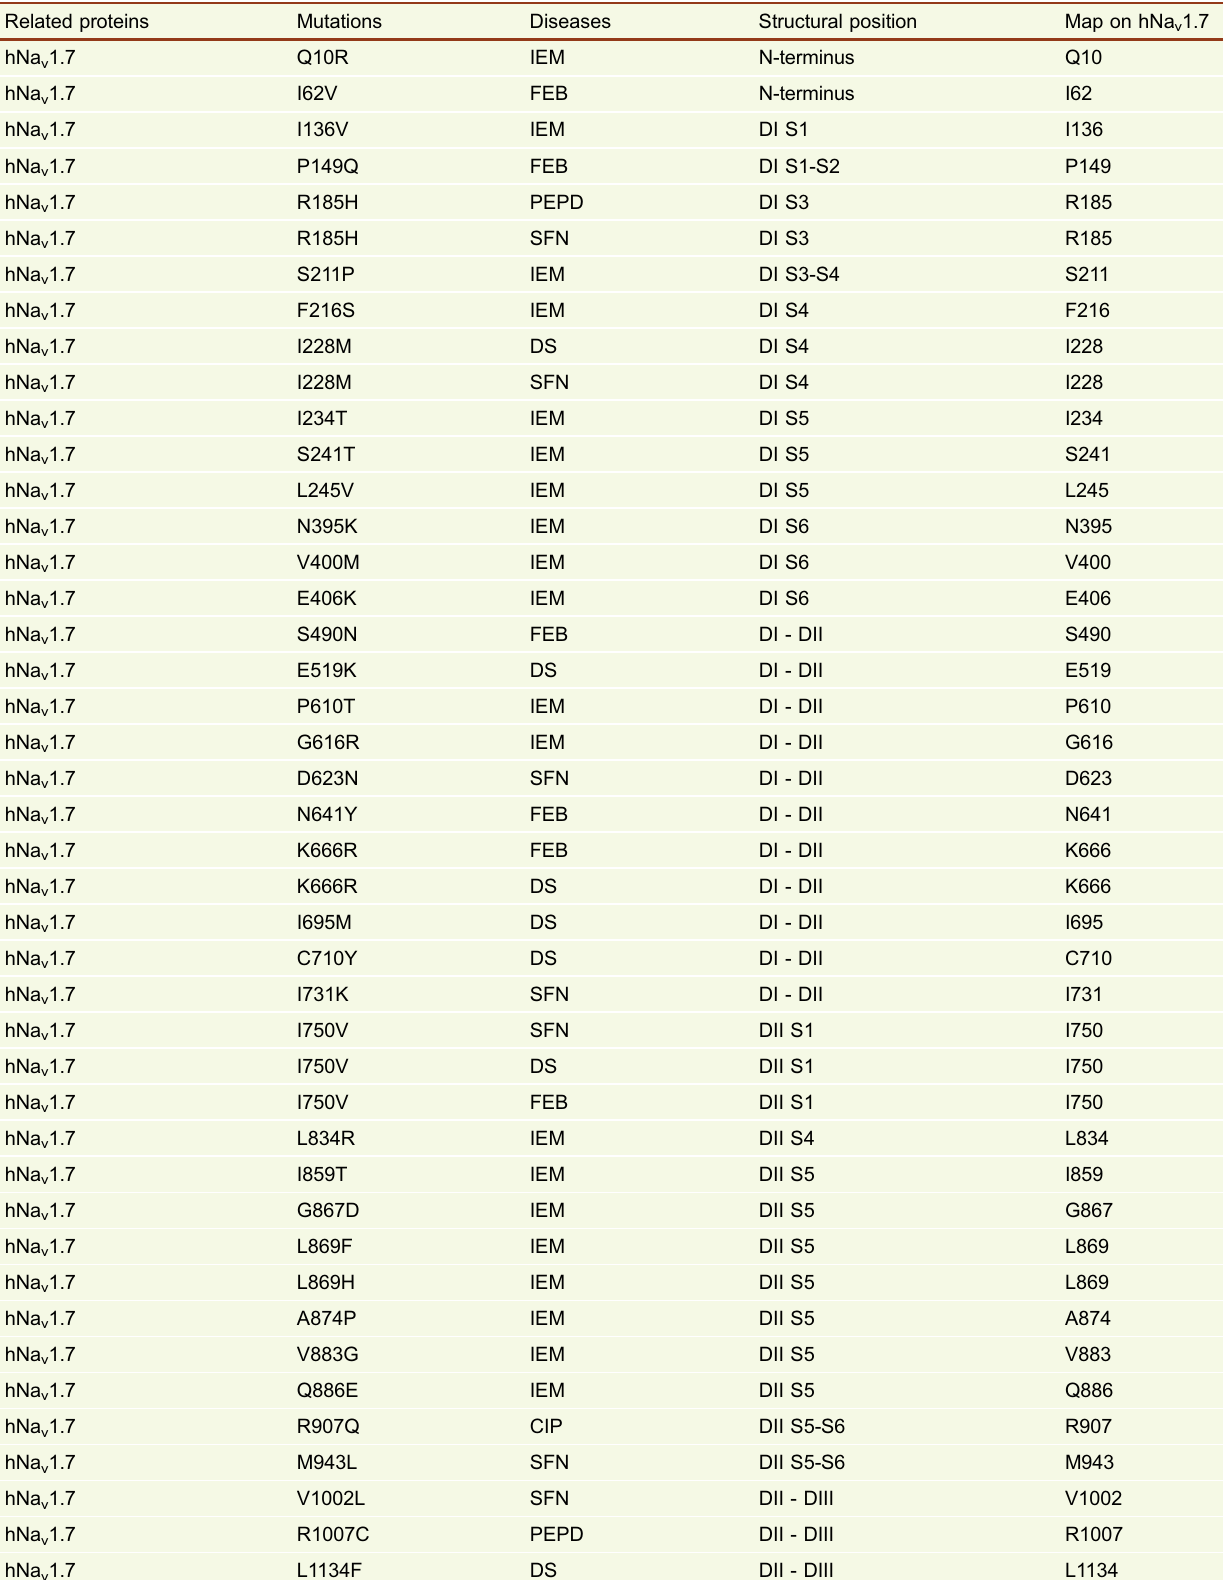
Table 1. Structural mapping of disease-related mutations identi fi ed in human Na v